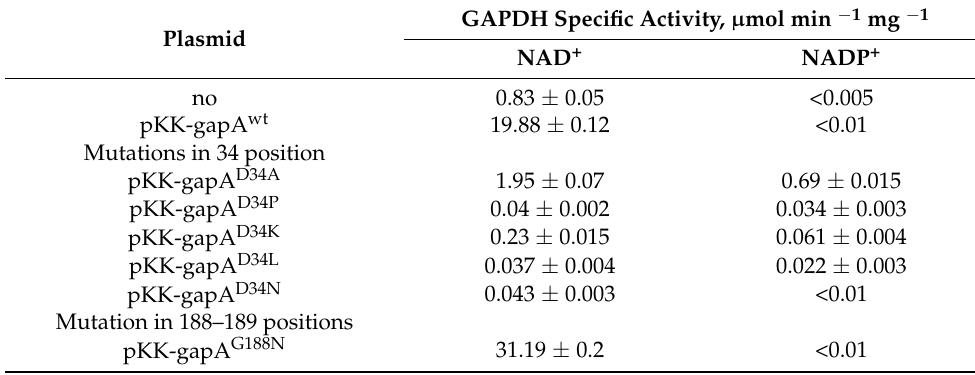
Table 4. NAD + /NADP + -dependent GAPDH activity in plasmid-harboring E. coli YA1461 ∆